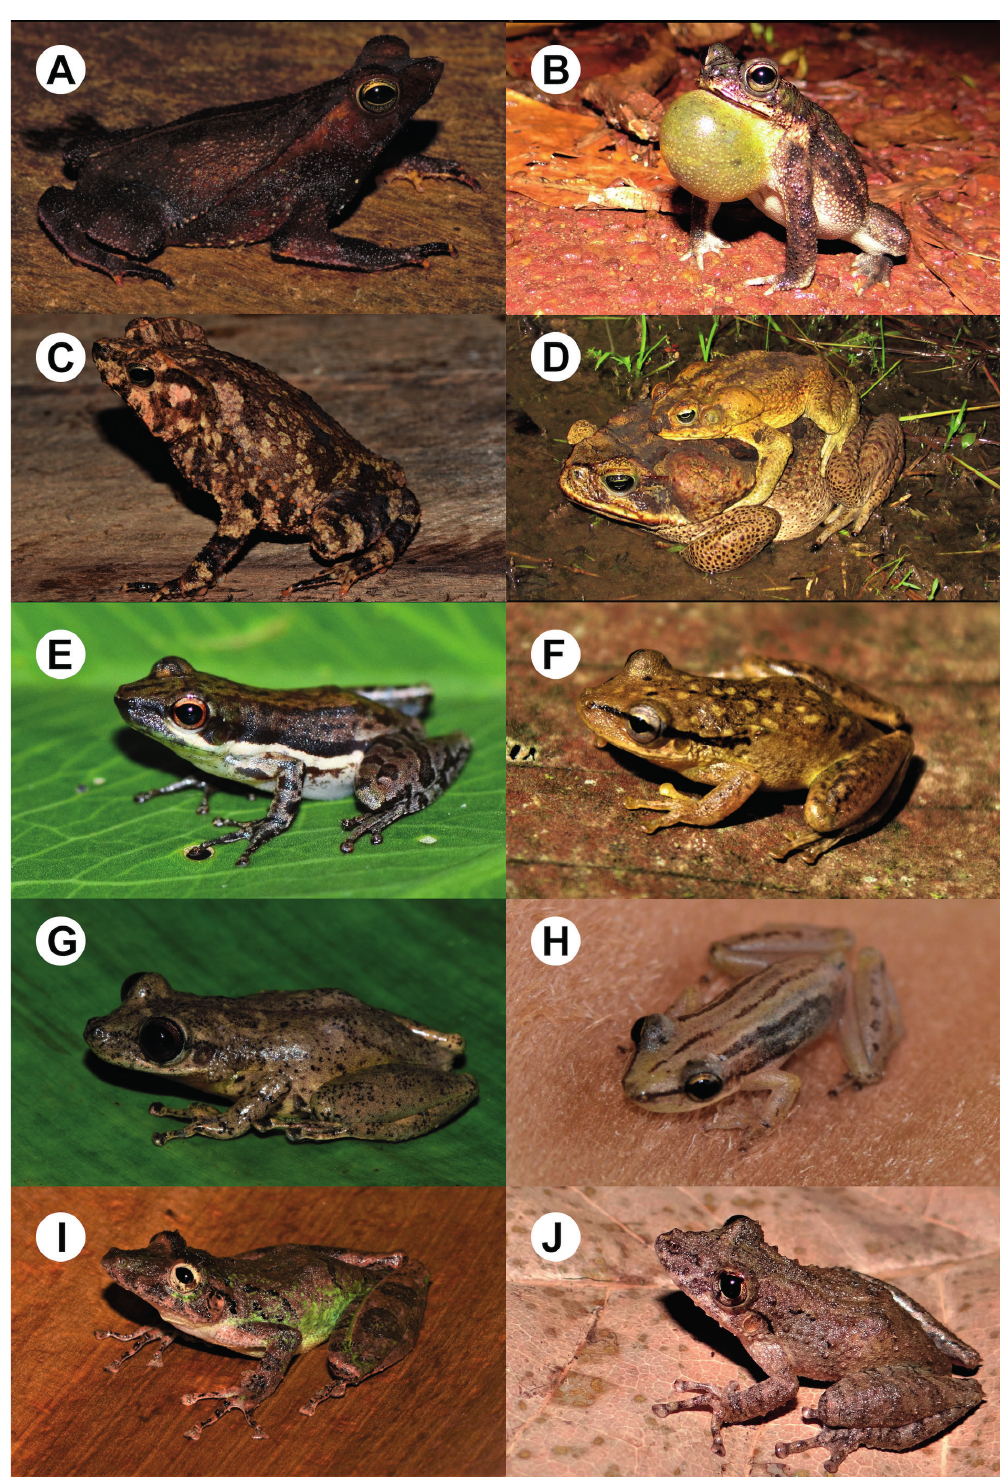
Fig. 8. Anuran species recorded in the state of Amapá. A . Rhinella aff. castaneotica . B . Rhinella major (Müller & Hellmich, 1936). C . Rhinella margaritifera (Laurenti, 1768). D . Rhinella marina (Linnaeus, 1758). E . Scarthyla goinorum (Bokermann, 1962). F . Scinax boesemani (Goin, 1966). G . Scinax cruentomma (Duellmann, 1972). H . Scinax fuscomarginatus (A. Lutz, 1925). I . Scinax jolyi Lescure & Marty, 2001. J . Scinax nebulosus (Spix, 1824) . Photos: C.E.